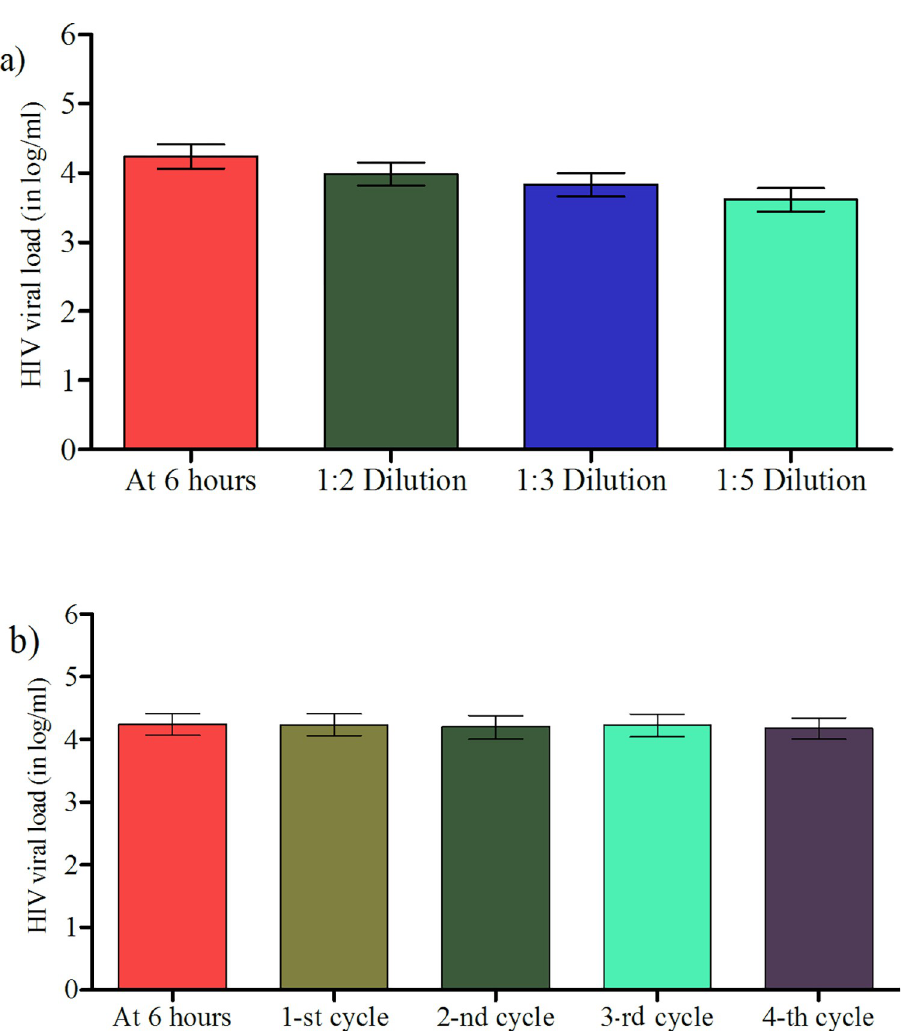
Fig 3. (a) HIV viral load measurement after dilution of plasma With PBS. (b) HIV viral load measurement after each of four cycles of